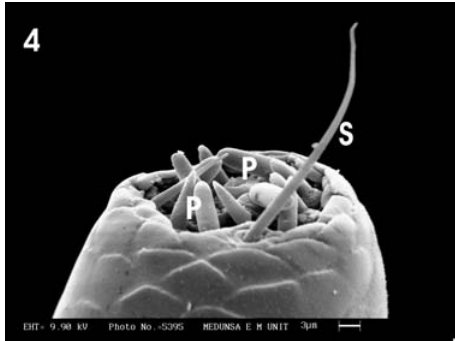
Fig. 4. The sensilla basoconica comprised 12 senso- ry pegs (P) and a long seta (S).